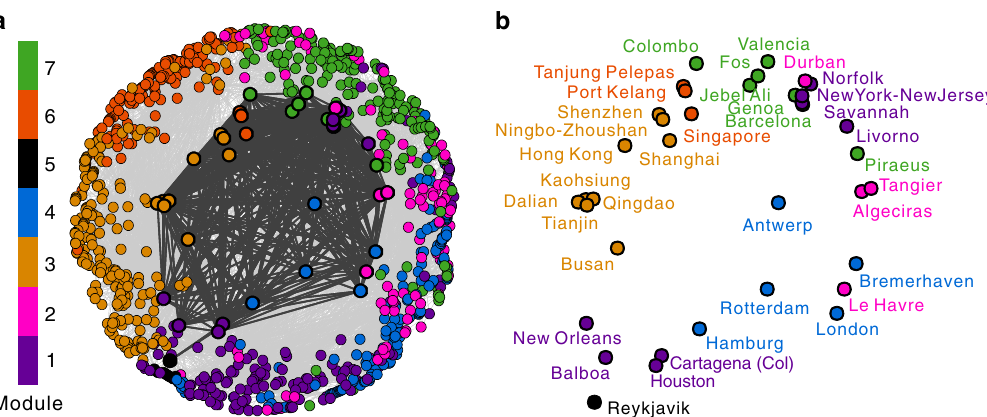
Fig. 7 Representation of the GLSN and its structural core in the hyperbolic space. The color of the nodes corresponds to the modular communities. In ( a ), the nodes belonging to the structural core are highlighted with a thicker black border and the intra-core connections are marked in dark gray, whereas the other connections are in light gray. Names of the structural-core ports are indicated in ( b ). The detected gateway-hub structural-core is at the center of the hyperbolic layout. Nodes at the center of this layout are crucial to support the ef fi cient navigability of a complex network 58 . From a previous analysis we know that these nodes at the center have also larger TEU (as presented in Fig. 1d). This indicates that the gateway-hub structural core is indeed mainly composed by ports with larger TEU that are fundamental for ef fi cient navigability of the network in transporting cargoes traded worldwide. Therefore, structural-core ports are important candidates to be associated with international trade (as we will analyse in the next section). In order to be sure that the hyperbolic representation is meaningful and the community separation is signi fi cantly and properly represented in the hyperbolic layout, we computed an index of angular separation of the communities (ASI) 61 in respect to the worst scenario in which the nodes of each community are equidistantly distributed over the circumference. This index is in the range [0,1]: 0 indicates the worst case, and 1 indicates a case of perfect angular separation. For the provided embedding the ASI is 0.7, which represents a good angular separation of the communities in the embedding space and is statistically signi fi cant with a p -value < 0.001 (see Supplementary Fig. 4 for details on the statistical